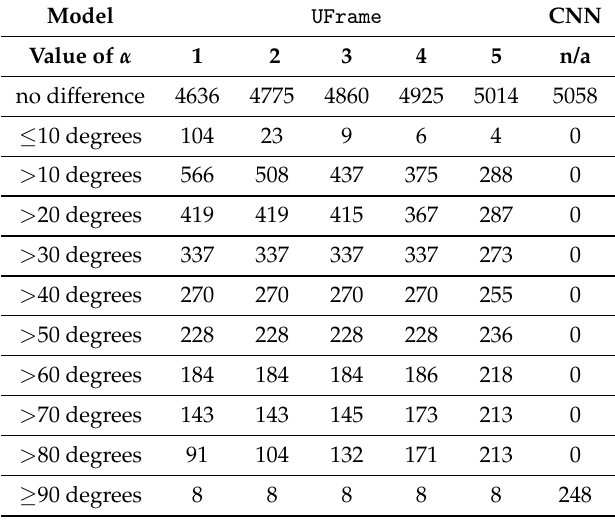
Table 4. Performance evaluation results: for different values of α , the number of samples with respect to the angle difference between the correct direction and the chosen direction by the CNN model and UFrame is shown below. The number of samples in the test dataset was